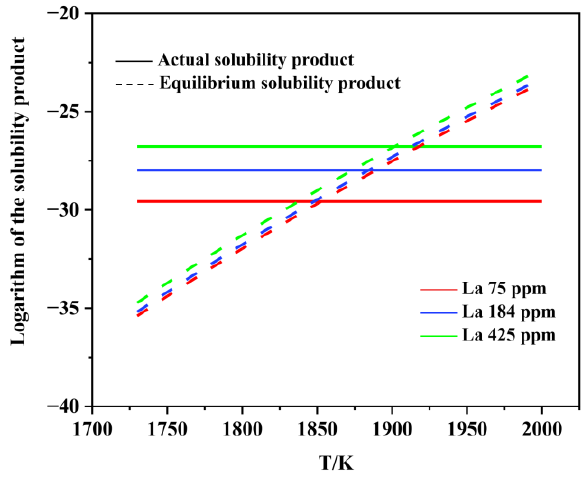
Figure 11. Logarithm of the solubility product as a function of temperature for La 2 S 3 in liquid steel.